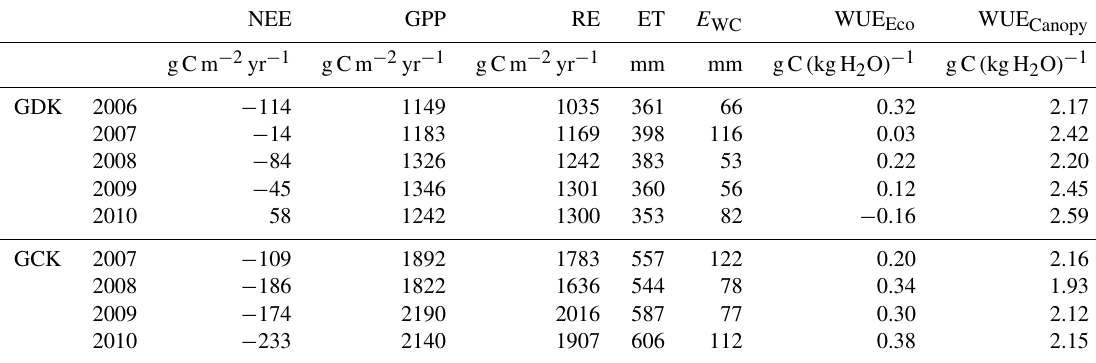
Table 2. The annual CO 2 and H 2 O budget (NEE, net ecosystem exchange; GPP, gross primary production; RE, ecosystem respiration; ET, evapotranspiration; E WC , wet canopy evaporation) and water use efficiency at the ecosystem level (WUE Eco ) and the canopy level (WUE Canopy ) for the study